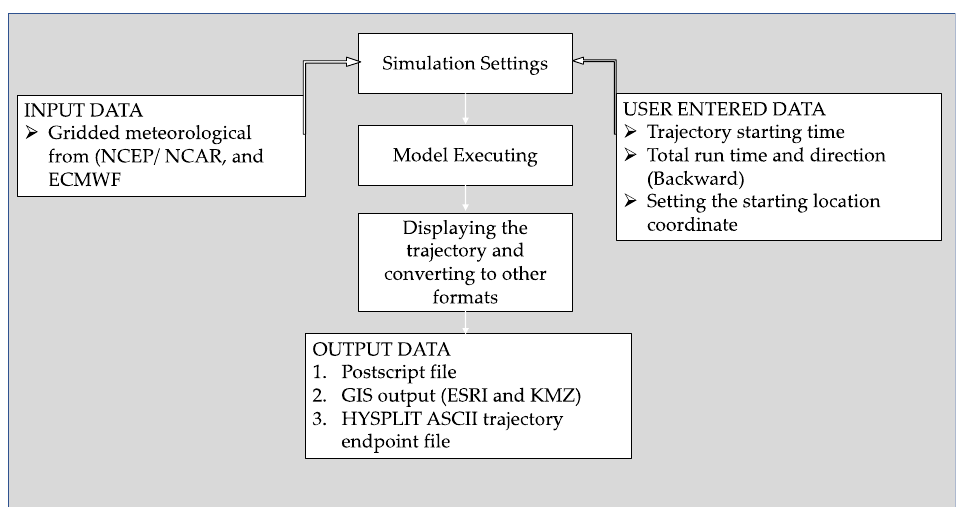
Figure 3. Complete flowchart of the overall settings, data sets, and output of the HYSPLIT model used in this